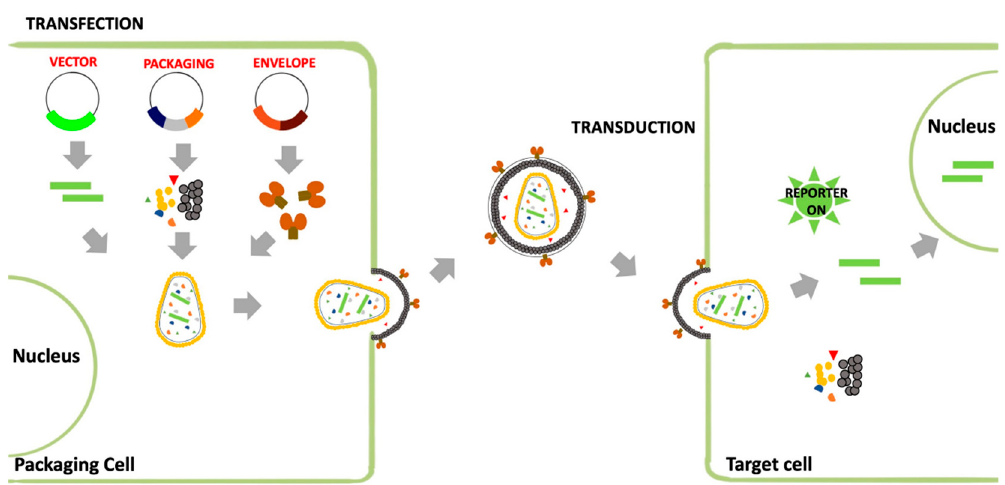
Figure 3. Schematic representation of the production of a pseudotyped retroviral vector. This system is based on a plasmid encoding for the retroviral vector ( cis -acting sequences, reporter gene), and constructs expressing the packaging system factors and the heterologous envelope